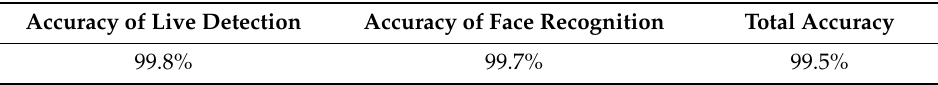
Table 4. Accuracy of the proposed algorithm.